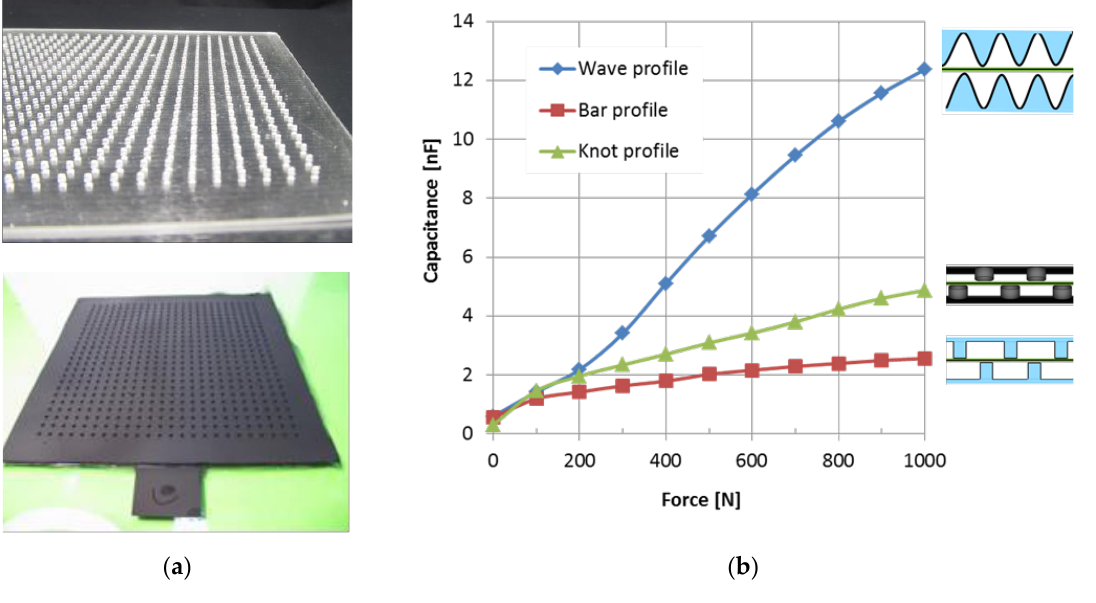
Figure 10. Photographs of elastomer sheets with knot profiles without and with electrode layer ( a ) and comparison of the dependence of the measured capacitance of pressure sensors with wave profiles, bar profiles and knot profiles on the applied force, where all profiles with an area of 100 mm × 100 mm are covered by electrode layers ( b ) [100].